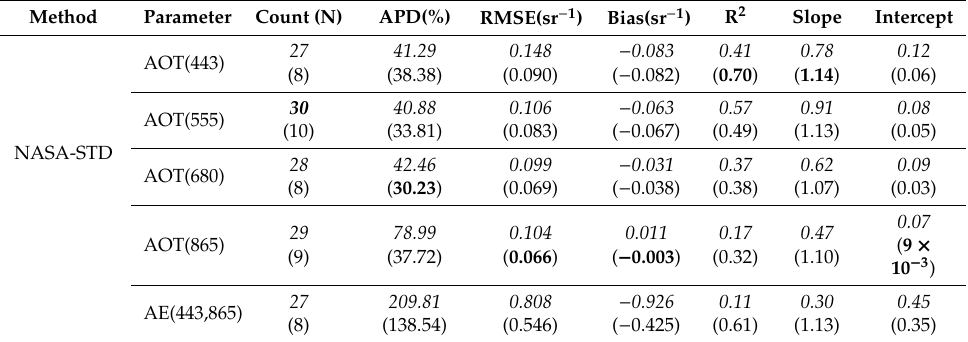
Table 6. Validation statistics for the NASA-STD method of GOCI-derived AOT(443), AOT(555), AOT(680), AOT(865), and AE(443,865) at 02:16, 03:16, and 04:16 UTC: APD (%), RMSE (sr − 1 ), Bias (sr − 1 ), R 2 (dimensionless), Slope (dimensionless), Intercept (dimensionless). Count (N) indicates the total number of match-ups. The italic numerals of each index represent ± 3 h, while the statistical results in parentheses are ± 1 h.